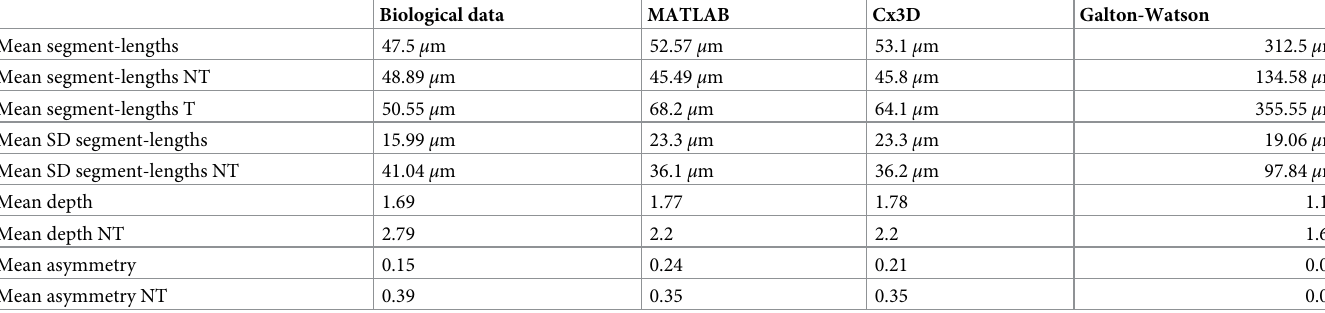
Table 2. Statistical properties of the floret dataset from cat thalamic axons and the three generated